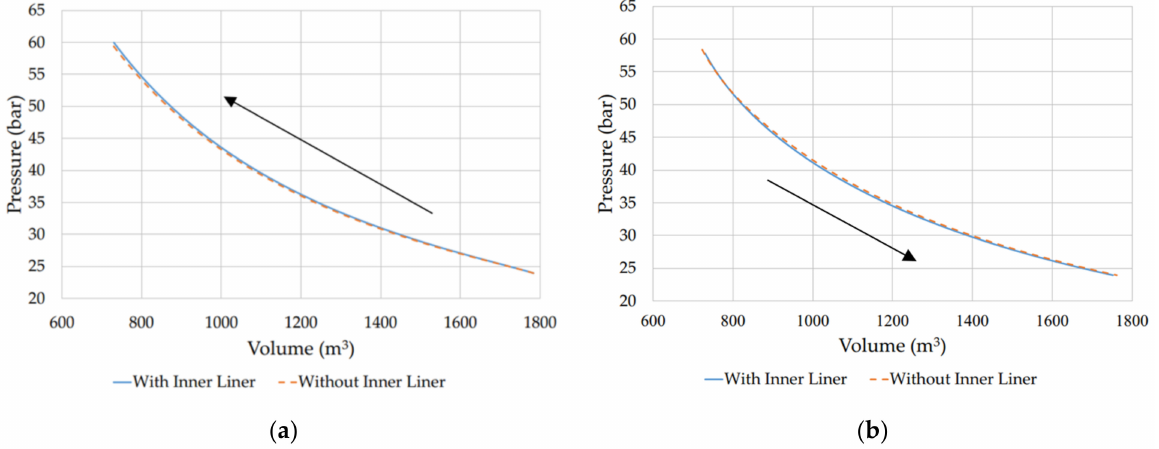
Figure 7. Pressure (bar) against volume (m 3 ) for the accumulator utilizing air as the compressible gas for ( a ) charging stage and ( b ) discharging stage, with arrows indicating direction of the